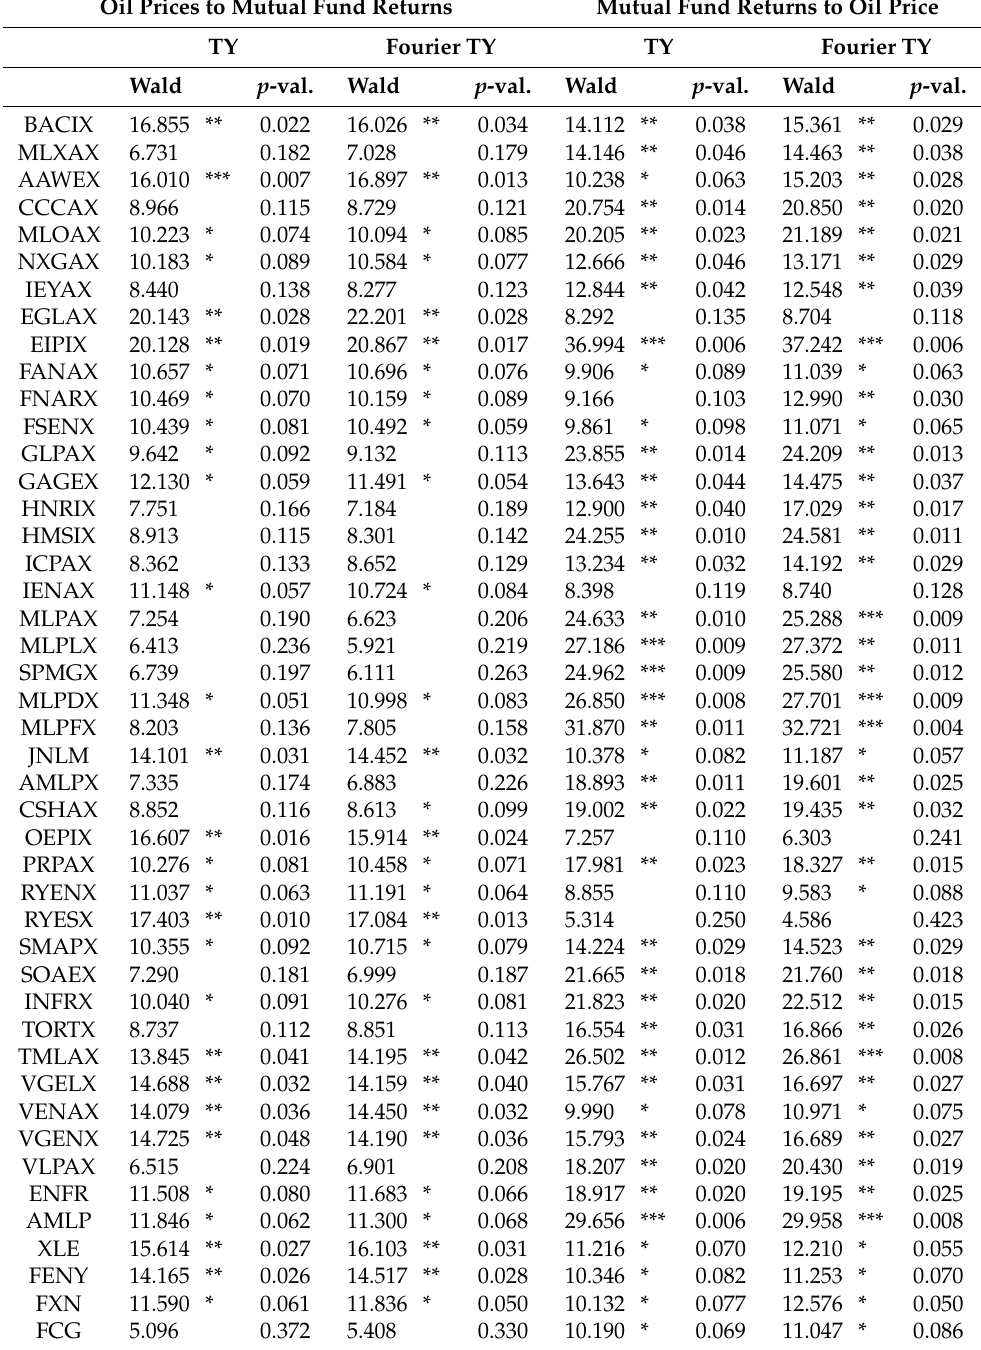
Table 3. Results for price transmission between oil prices and mutual fund